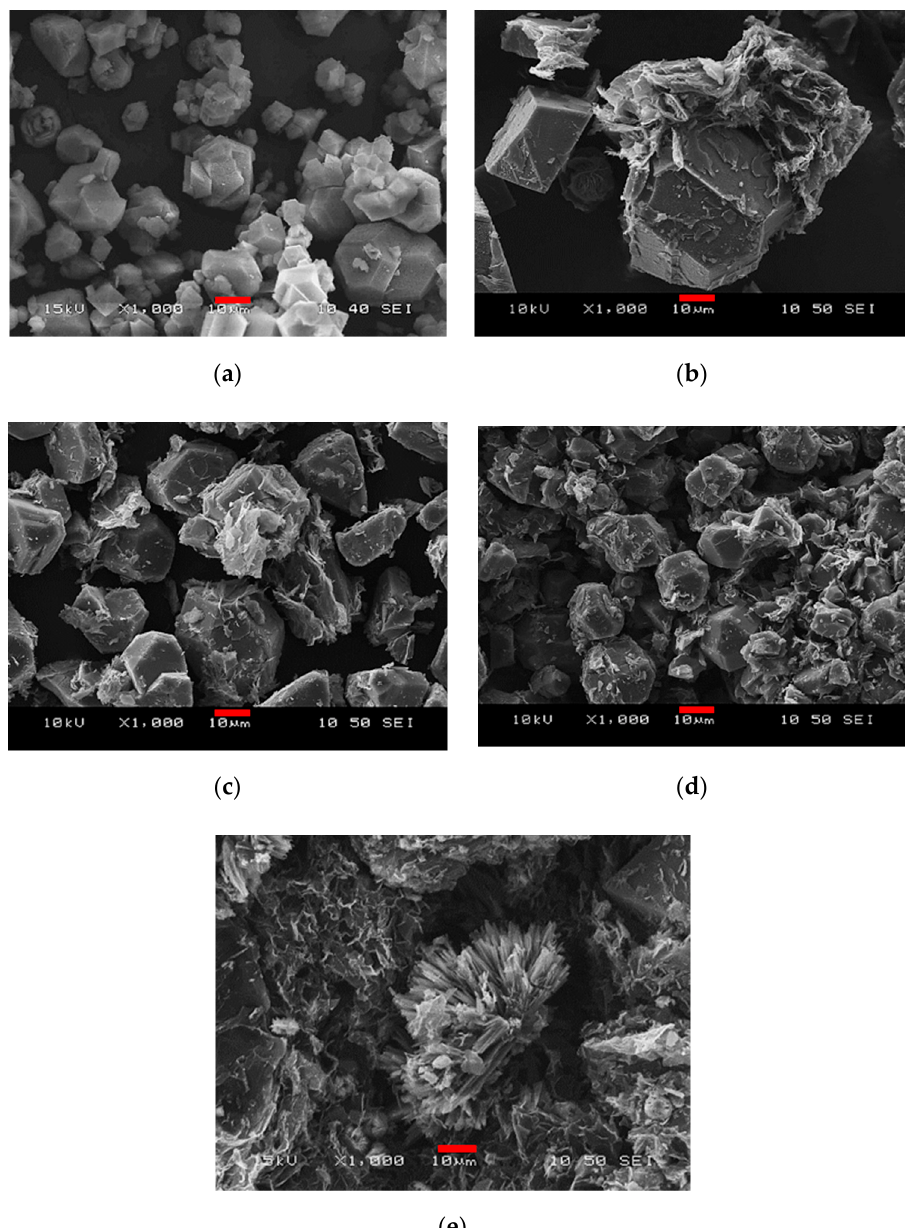
Figure 1. Scanning electron microscopy (SEM) images of ( a ) copper benzene-1,3,5-tricarboxylate (Cu 3 (BTC) 2 or HKUST-1), ( b ) HKUST-1@GO (graphene oxide)-1, ( c ) HKUST-1@GO-1.5, ( d ) HKUST-1@GO-2 and ( e ) HKUST-1@GO-2.5. The scalebar is 10 µm.